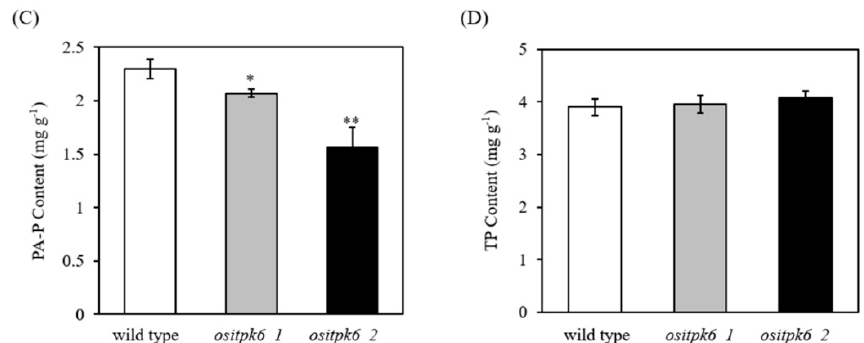
Figure 4. Inorganic P (Pi), phytic acid P (PA-P), and total phosphorus (TP) contents of the mutant OsITPK6 lines and the wild type. ( A ) Qualitative assay of inorganic phosphorus (Pi) in mutant seeds. The concentration of the Pi standard samples is shown above. Five replicates were performed for two OsITPK6 mutant lines and the wild type. ( B – D ) Six replicates were performed for two OsITPK6 mutant lines and the wild type. Error bars represent the standard error. Data with an asterisk(s) are significantly different with respect to the wild-type data (* p < 0.05, ** p < 0.01).